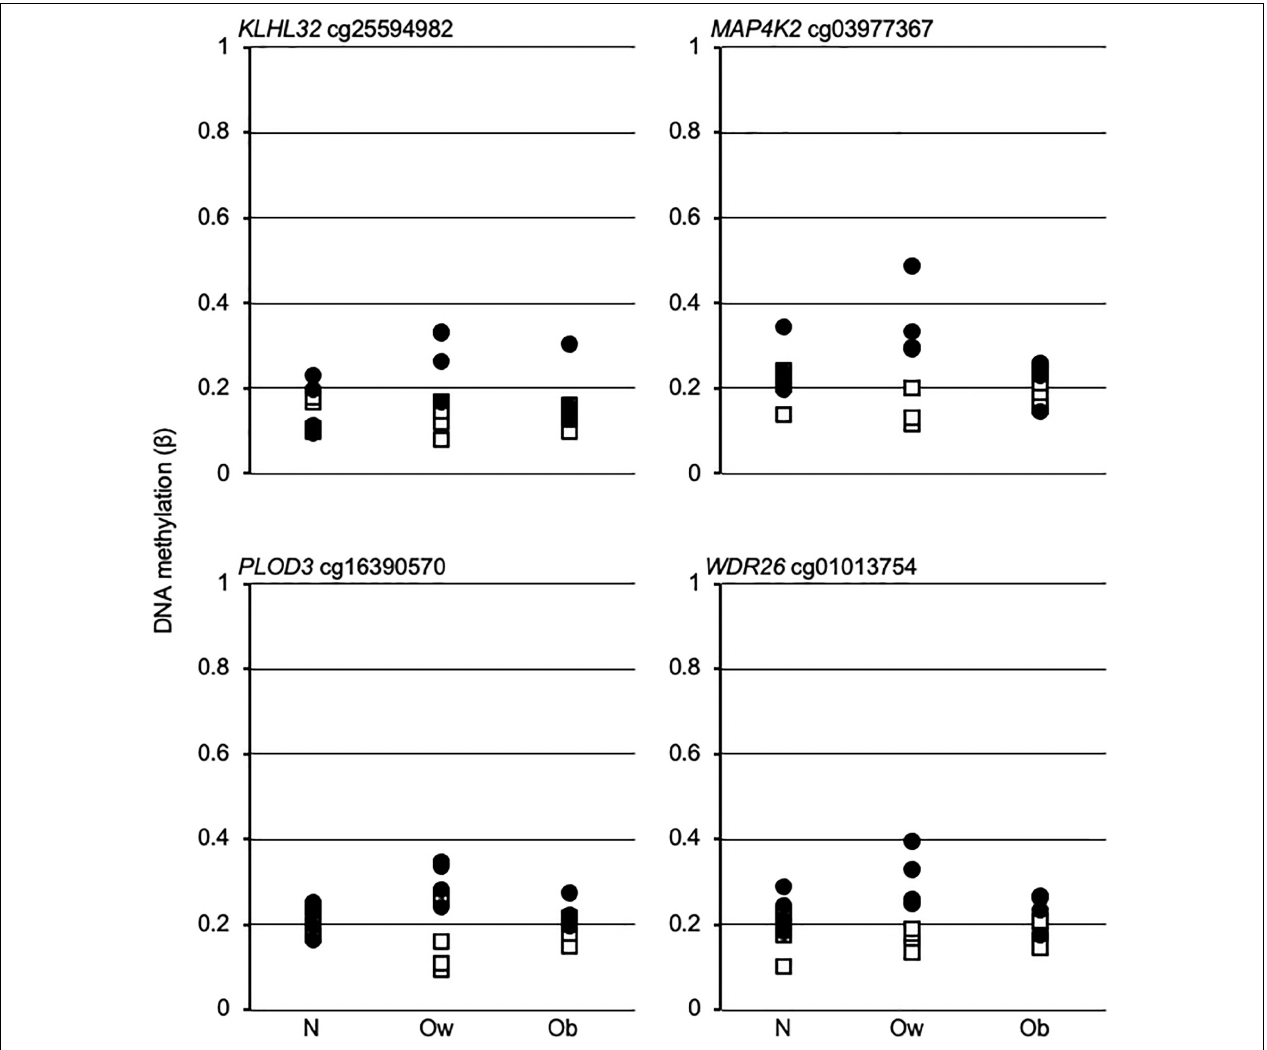
FIGURE 4 | DNA methylation trend in fasting and postprandial states across BMI classes. Open squares and solid circles, fasting and postprandial state, respectively. Gene name and EPIC array Ow-dmCpG ID are indicated above each graph. N, Ow, and Ob, normal weight, overweight and obese, respectively.